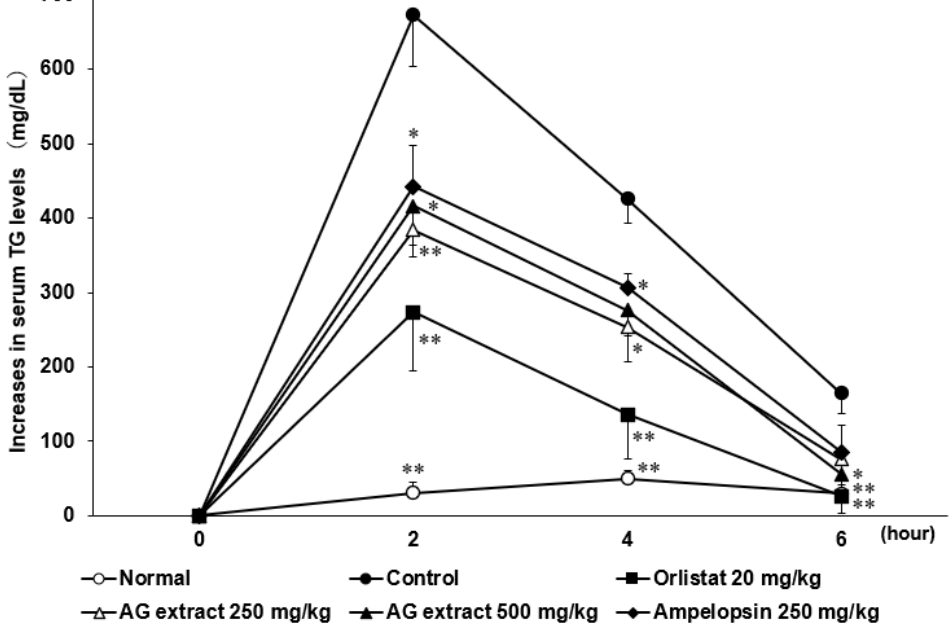
Figure 4. Effects of AG extract and ampelopsin on lipid absorption in olive oil-loaded mice. Each symbol represents the mean ± SE ( n = 6). Data were assessed by a one-way analysis (ANOVA) of variance followed by Dunnett’s method. Asterisks denote significant differences from the control group at * p < 0.05, ** p < 0.01.